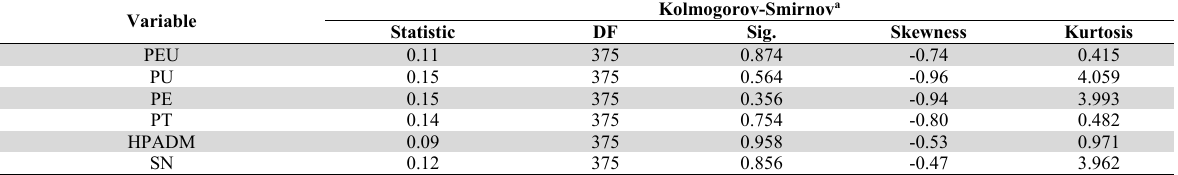
Normal distribution of research variables